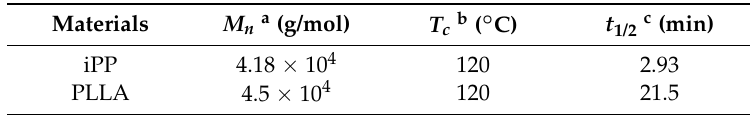
Table 1. A comparison on the crystallization rate of iPP and PLLA.